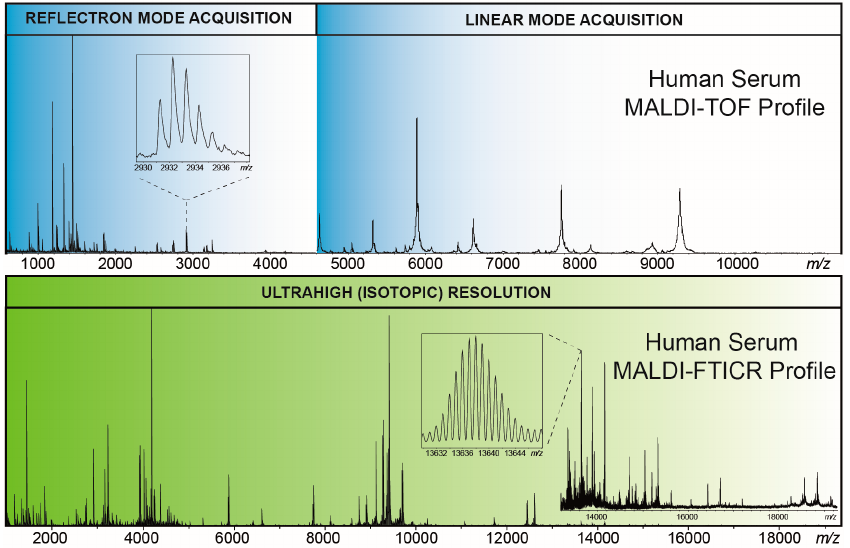
Figure 1. Early (in blue) and current (in green) matrix-assisted laser desorption/ionization (MALDI)-based serum peptide and protein profiles obtained after reversed-phase (RP) C18-magnetic bead cleanup. The MALDI-time-of-flight (TOF) profile in the upper panel is composed of a low-resolution linear mode spectrum (up to m / z -value 11,000) and a high-resolution reflectron mode spectrum (up to m / z -value 4600); in the lower panel a MALDI- Fourier transform ion cyclotron resonance (FTICR) profile of the same sample is